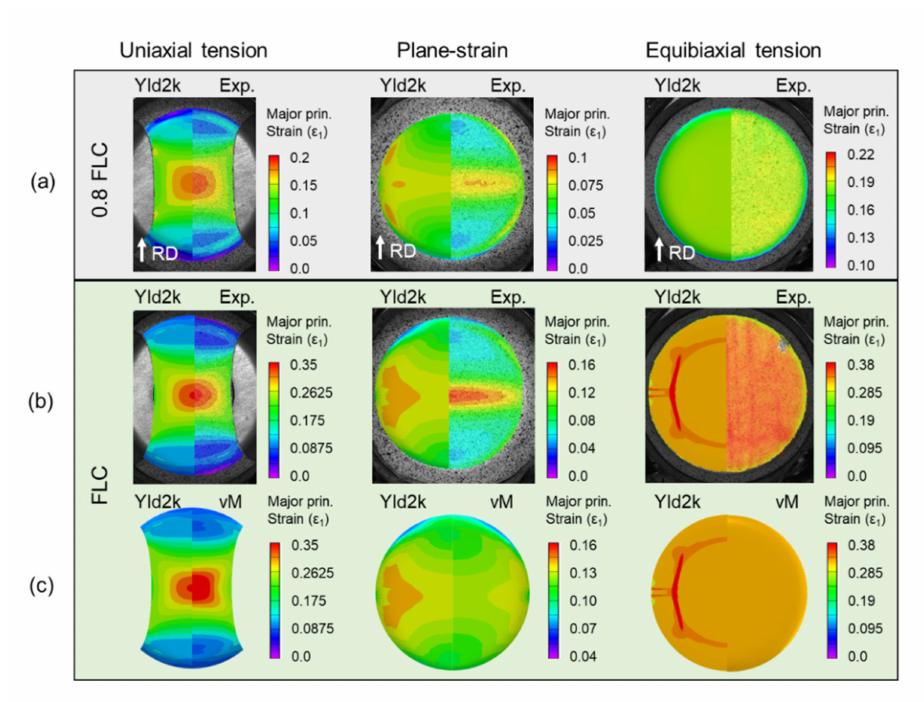
Figure 22. Contours of major principal strain for the FLC experiments and predictions ( a ) at 0.8 FLC and ( b ) FLC, and ( c ) comparison of Yld2000-2d and von Mises at FLC. The strain levels are di ff erent, as appropriate in each